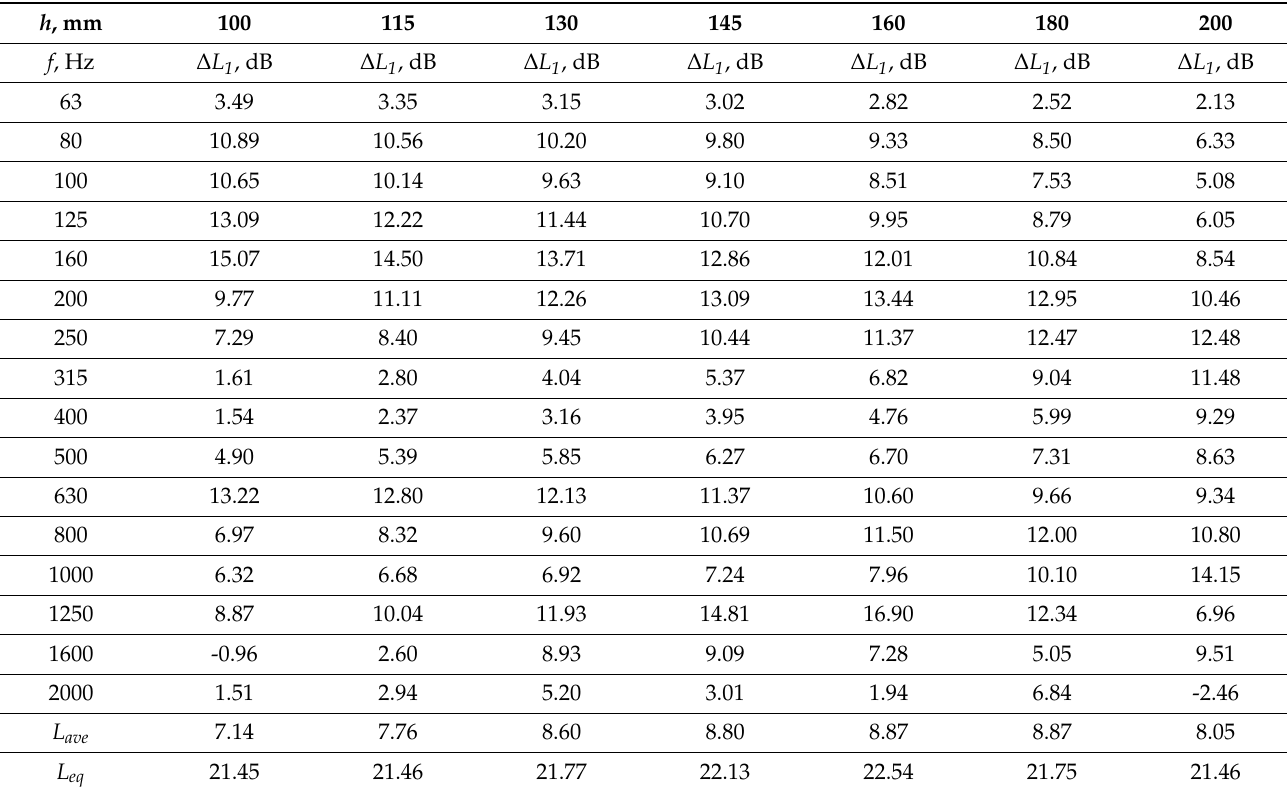
Table 2. Results for calculations for ∆ L 1 at third-octaves for area 1 at a/b =